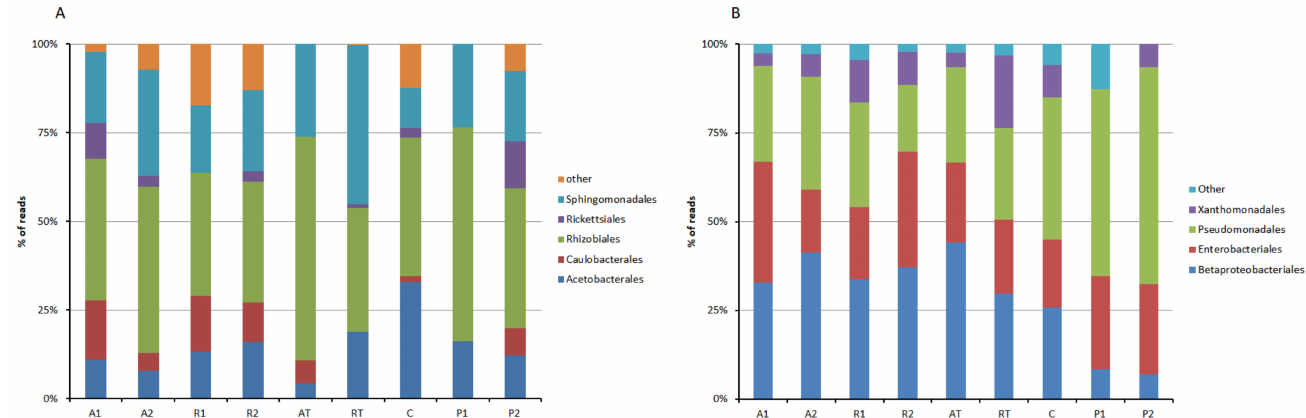
Figure 4. Order-wise distribution of Alpha-Proteobacteria ( A ) and Beta-Proteobacteria ( B ) in bee bread and bee pollen samples (A1 and A2 = bee breads collected from two colonies fed with oak pollen patty; R1 and R2 = bee breads collected from two colonies fed with rapeseed pollen patty; AT = bee bread collected from colony fed on oak pollen patty with restricted inflow of pollen from outside; RT = bee bread collected from colony fed on rapeseed pollen patty with restricted inflow of pollen from outside; P1 and P2 = bee pollen collected from bee hives equipped with pollen trap; C = bee bread collected from control